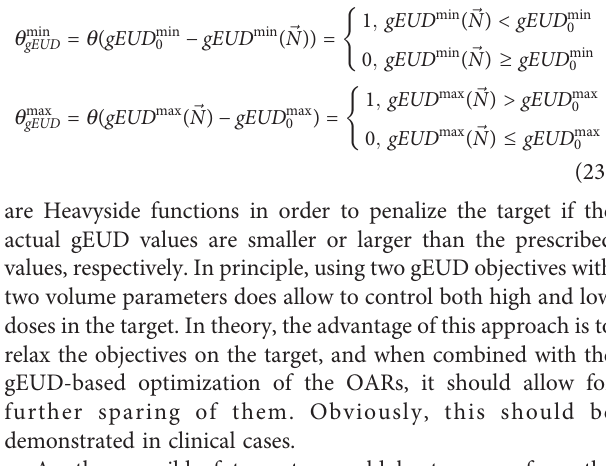
FIGURE 7 | Normal tissue complication probability (NTCP) curve for the right parotid gland of patient plan 335, calculated according to Lyman – Kutcher – Burman (LKB model) using the parameters obtained by Dijkema et al. (29). The error bars were calculated considering the maximum and minimum NTCP values coming from the combination of the extreme values of the parameters TD 50 and m (95%CIs): TD 50 = 37.3 Gy and m = 0.51 for the highest NTCP value, and TD 50 = 42.8 Gy and m = 0.34 for the lowest NTCP. A therapeutic plan of 20 fractions of 3 Gy is considered, with EQD2